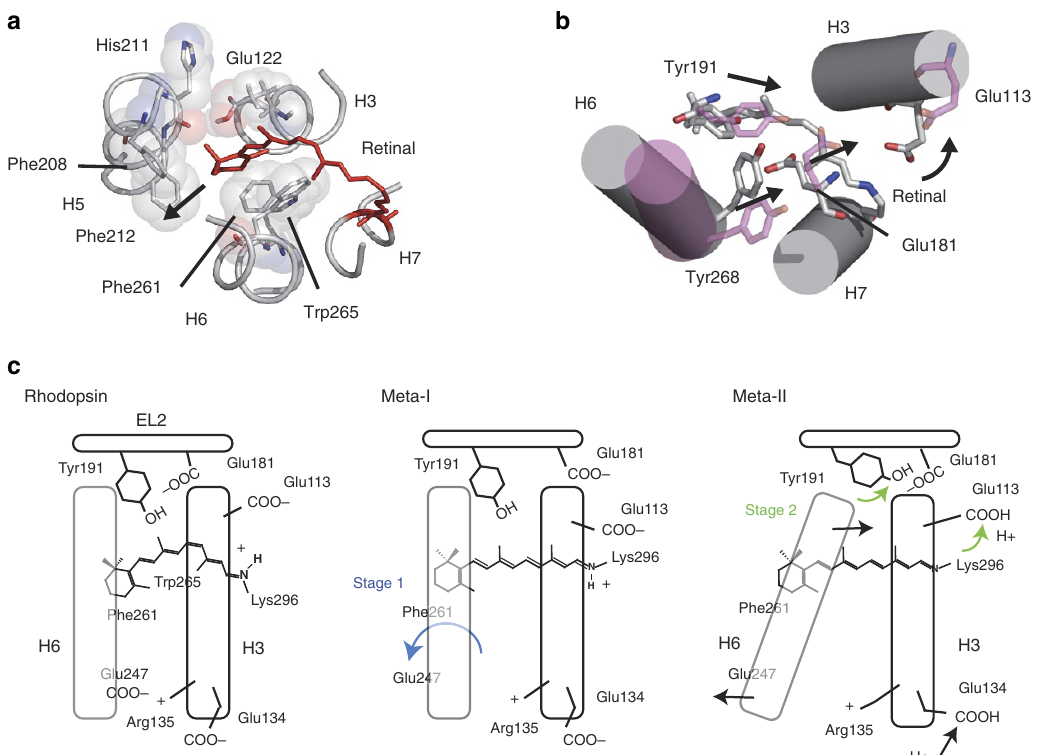
Figure 5 | Two-stage trigger mechanism for rhodopsin activation. ( a ) Residues interacting with the b -ionone ring in the dark state of rhodopsin (PDB-ID 1U19; ref. 26). The first stage of the two-stage trigger involves isomerization of the 11- cis -retinal chromophore within a tightly packed retinal-binding pocket. Steric interactions arise because the shape of the retinal-binding site fits the 11- cis isomer but does not accommodate the longer all- trans form 10 . The position of the b -ionone ring defined by distance measurements with Met207 5.42 and His211 5.46 on H5 (Supplementary Fig. 3 and refs 18,19), as well as Phe261 6.44 and Trp265 6.48 on H6 (Fig. 1 and refs 18,19,63) are consistent with strong steric interactions between the b -ionone ring in this region of the retinal-binding site. Motion of H5 and H6 is present at the Meta I stage as a result of isomerization 38,39,42 . ( b ) Cartoon representation of the structural changes occurring on the extracellular side of the retinal-binding site in rhodopsin comprising the second stage of the two-stage trigger. Retinal isomerization leads to a change in the position of Glu181 EL2 in Meta-I (ref. 35). Deprotonation of the retinal PSB and protonation of Glu113 3.28 leads to a further rearrangement of the hydrogen-bonding network connecting Glu113 3.28 to Tyr191 EL2 . Both Tyr268 6.51 and Tyr191 EL2 shift towards Glu181 EL2 to maintain hydrogen-bonding interactions. The proposed motion of the extracellular side of H6 due to Tyr191 EL2 motion is coupled to the outward pivot of the intracellular side of H6. ( c ) Schematic representation of the two-stage trigger